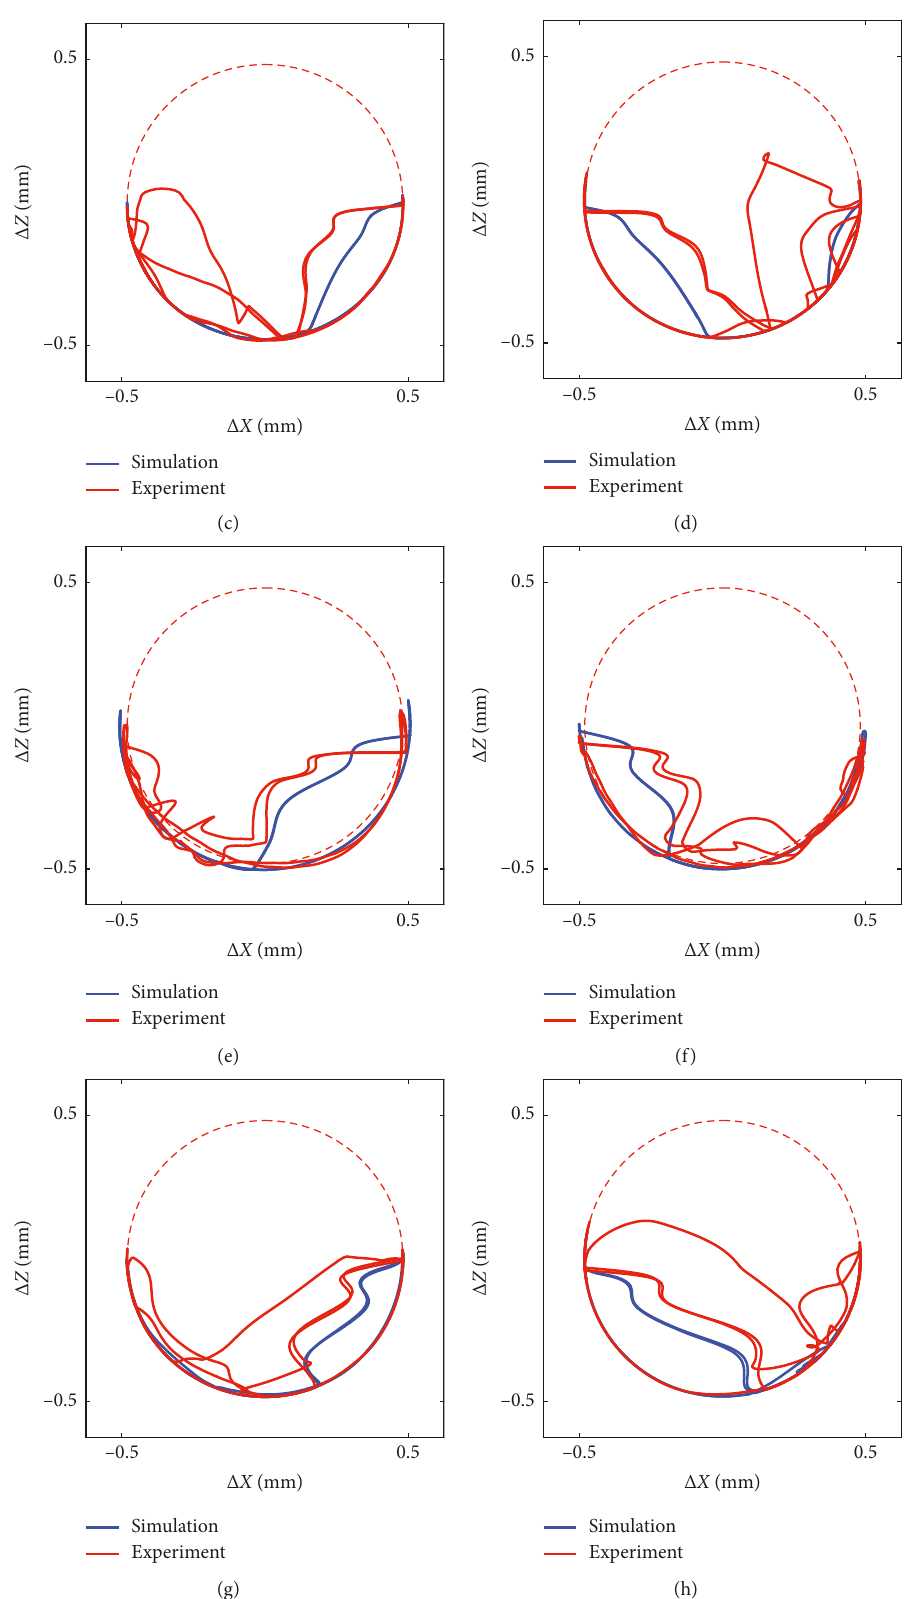
Figure 22: Trajectories in numerical simulation and experiment with different F trajectories at F max � 1kN, (c) left trajectories at F max � 2 kN, (d) right trajectories at F max � 2kN, (e) left trajectories at F max � 3kN, (f) right trajectories at F max � 3kN, (g) left trajectories at F max � 4kN, and (h) right trajectories at F max � 4